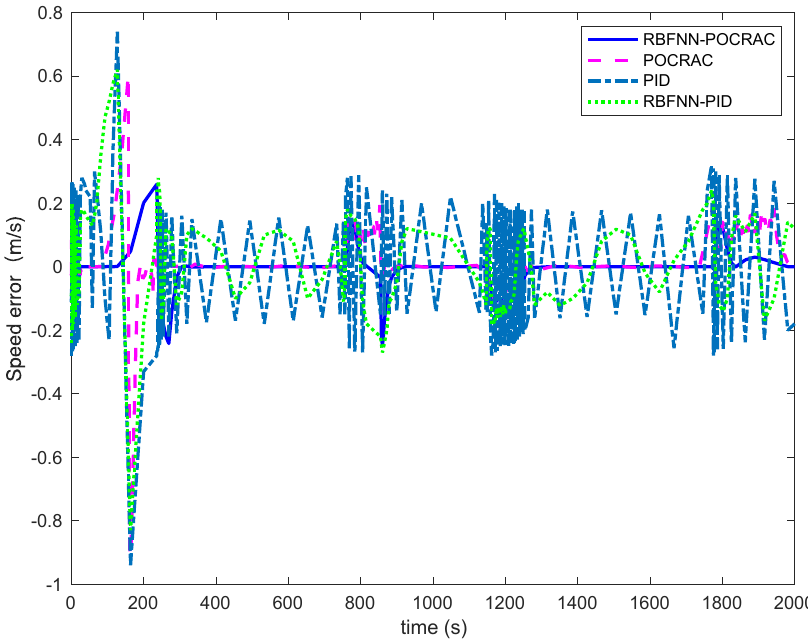
Figure 10. Speed error comparison.